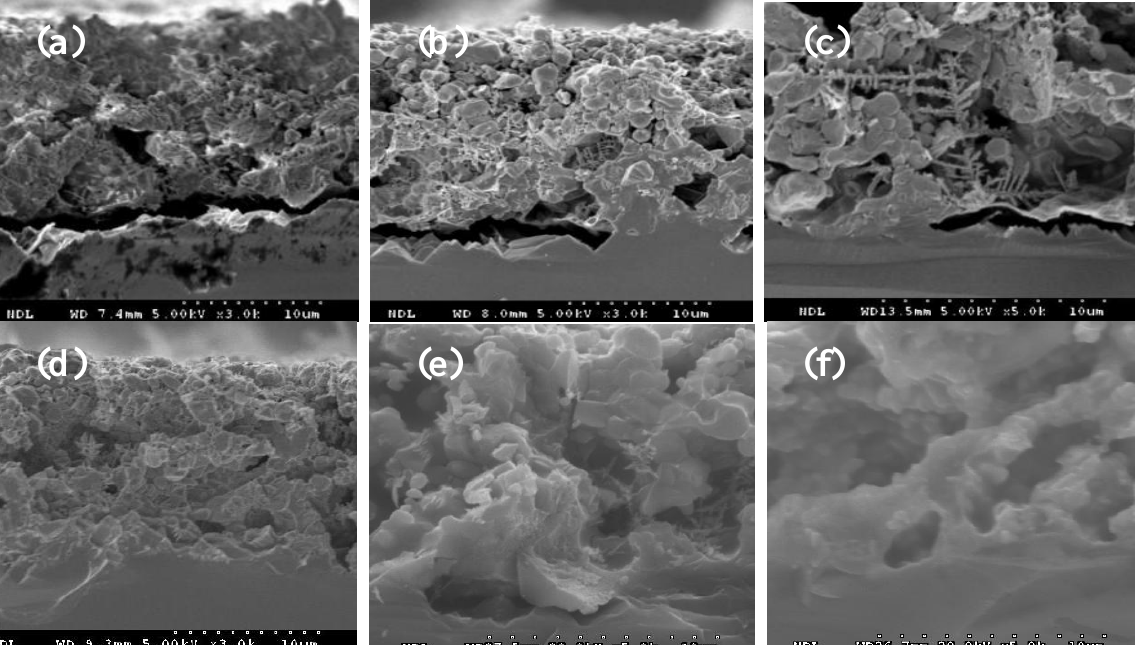
Figure 2. Cross-section images of screen-printed texture-barrier (SPTB) layer/p-type Si(100) substrates fired at 840 °C for ( a ) 10, ( b ) 20, ( c ) 40, ( d ) 60, ( e ) 80, and ( f ) 100 min, respectively, and textured in a 1.7% KOH solution for 25